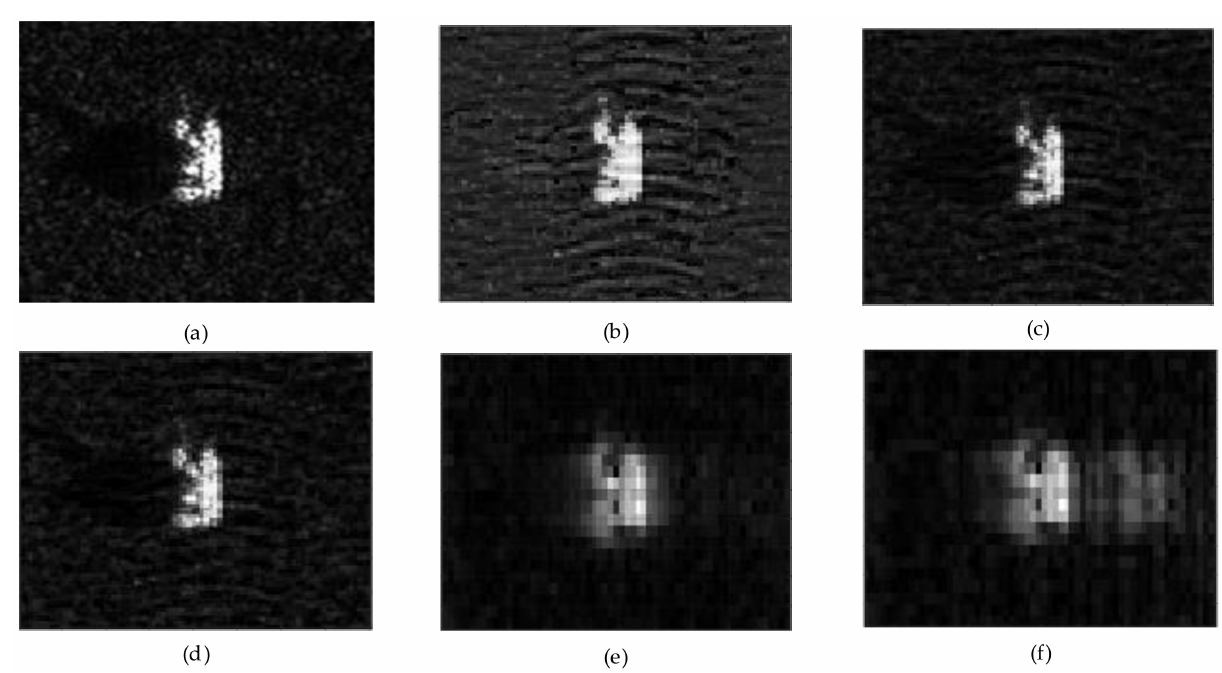
Figure 4. T72 imaging results. ( a ) is original vehicle target, ( b ) is our proposed method with L = 3, ( c ) is our proposed method with L = 8, ( d ) is our proposed method with L = 11, ( e ) is ISTA method and ( f ) is Fast ISTA method.